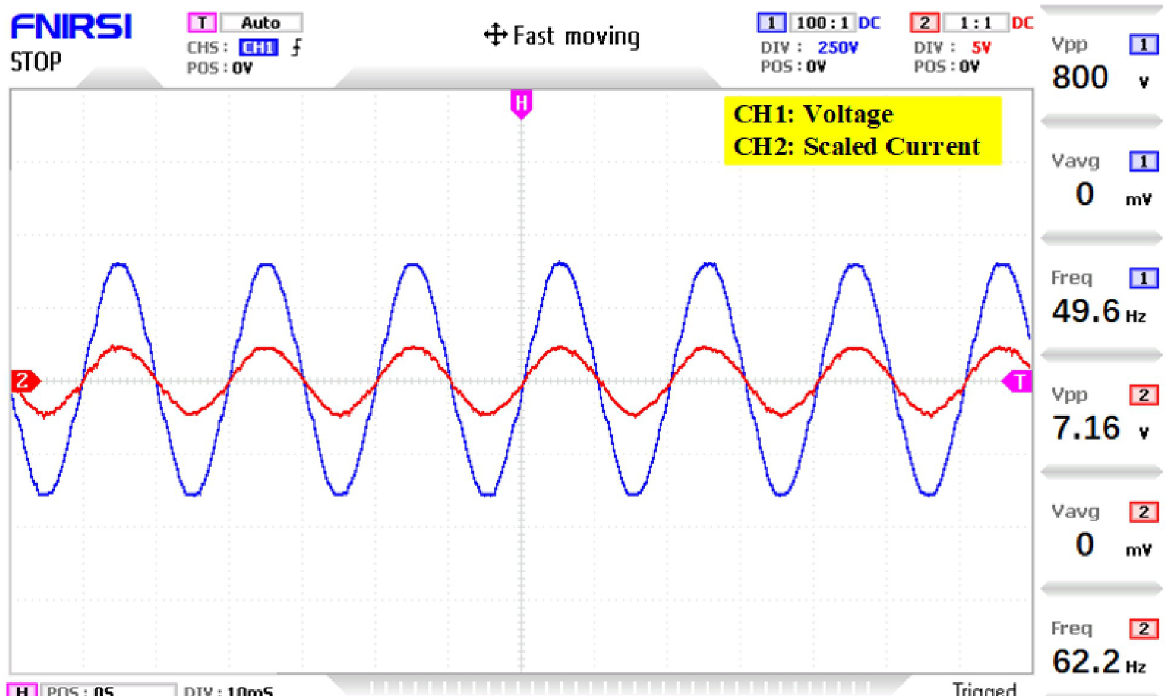
Fig 22. Experimental waveforms (voltage and current) at the output of 81-level MWMLI for resistive load.